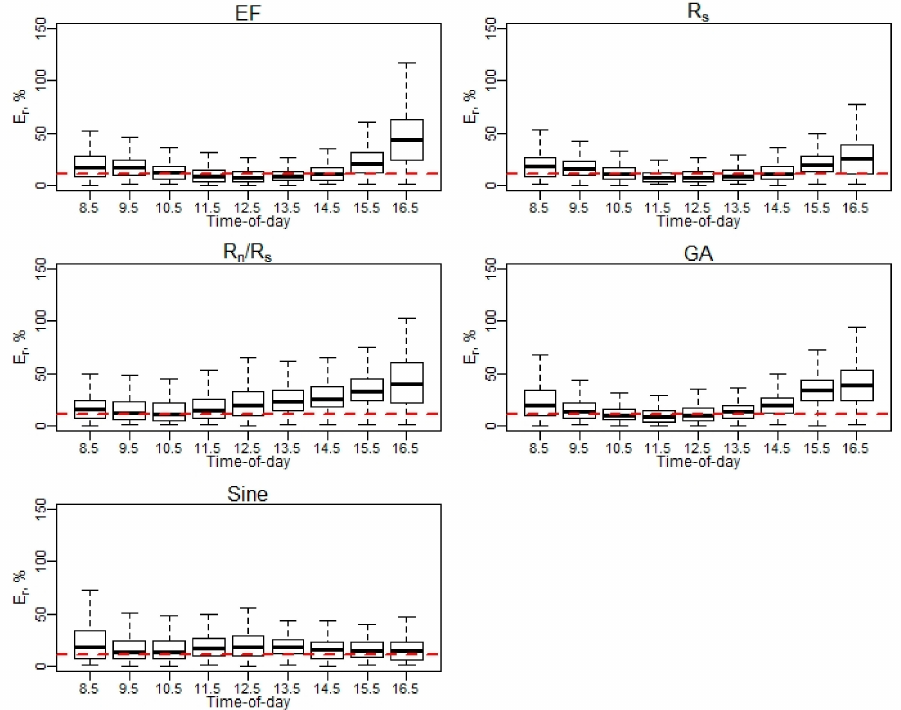
Figure A1. E r of daily EC ET (April–May).